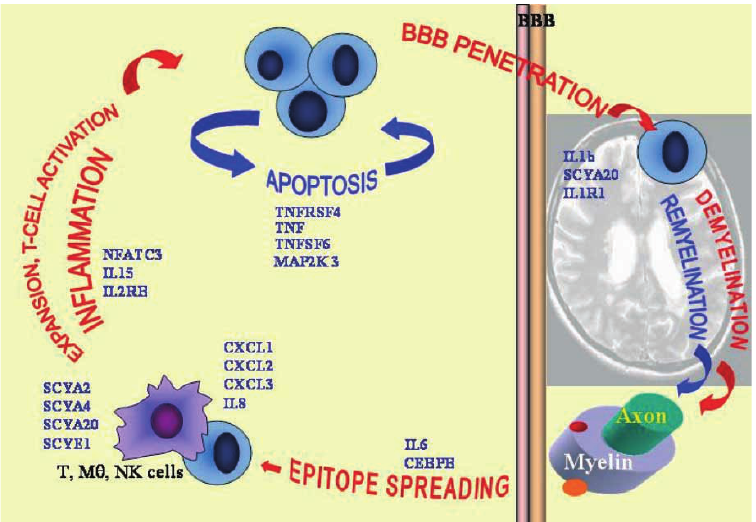
FIGURE 2 Principle scheme of the cytokine-related pathways involved in MS pathogenesis. BBB-blood brain barrier; NK-natural killer;